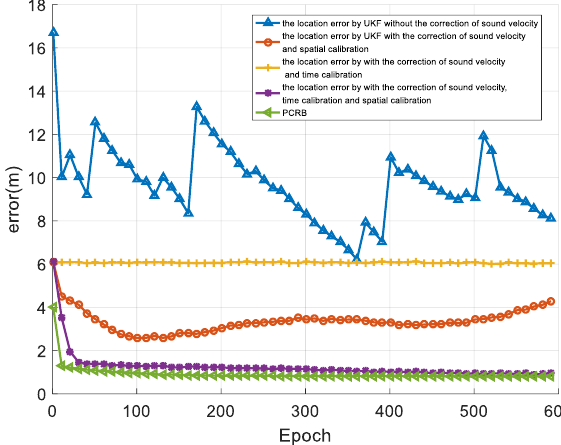
Figure 11. The positioning results of different methods. Table 2. Comparison of the position results of different methods.